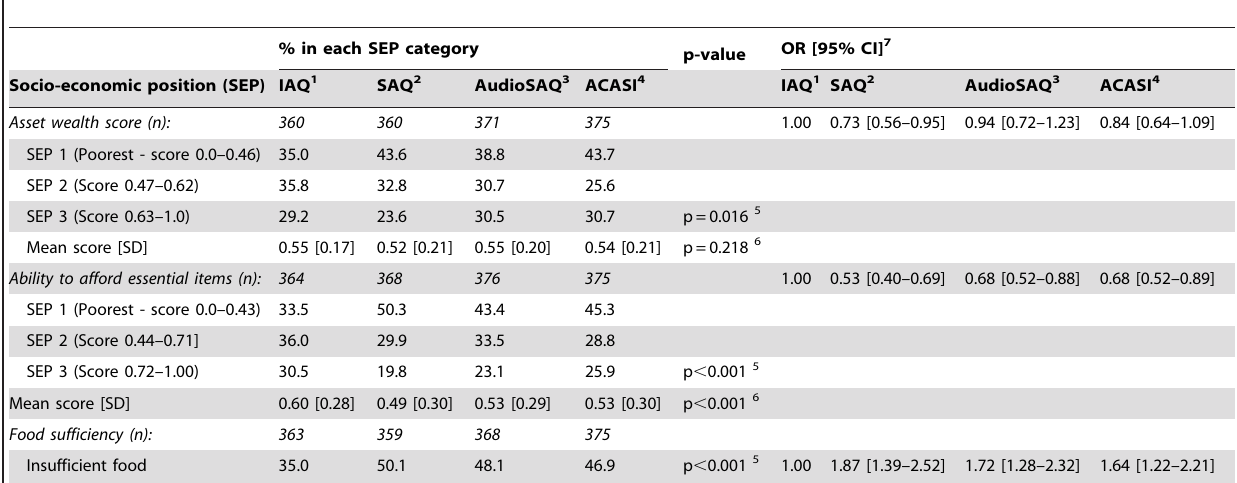
Table 3. Relationship between classification of socio-economic position and questionnaire delivery mode for each socio-economic